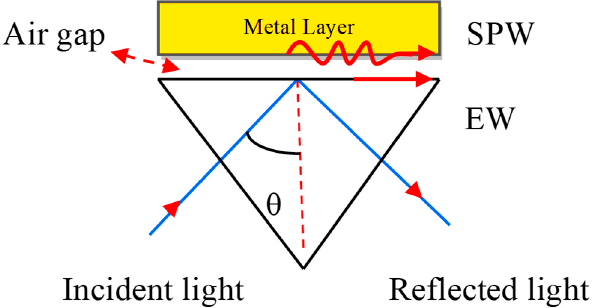
Figure 3. Otto configuration. Here, EW stands for Evanescent Wave and SPW refers to the Surface Plasmon Wave.